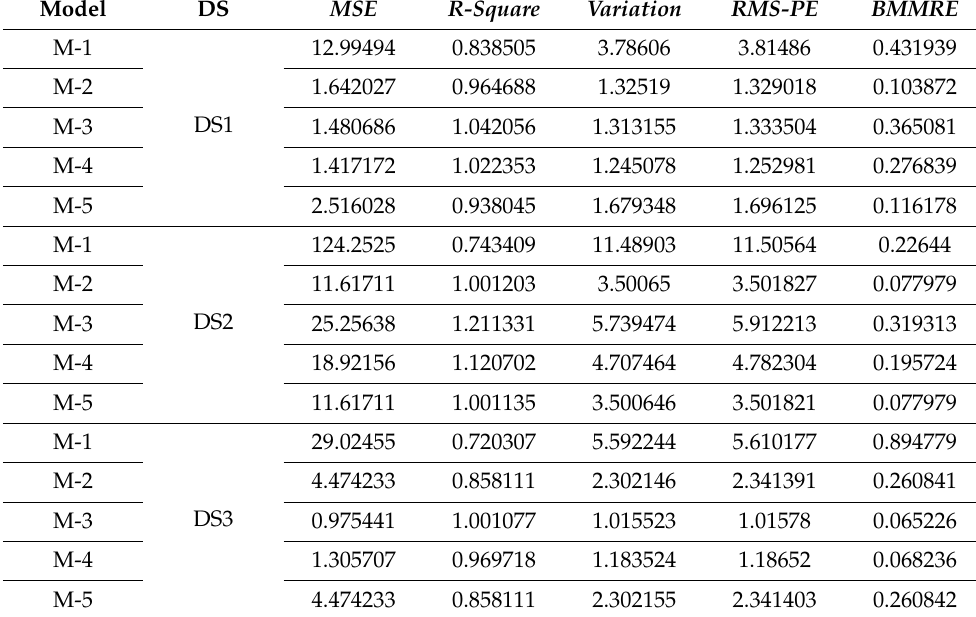
Table 4. Comparison of Fitting Performance of M-1~5 Models.